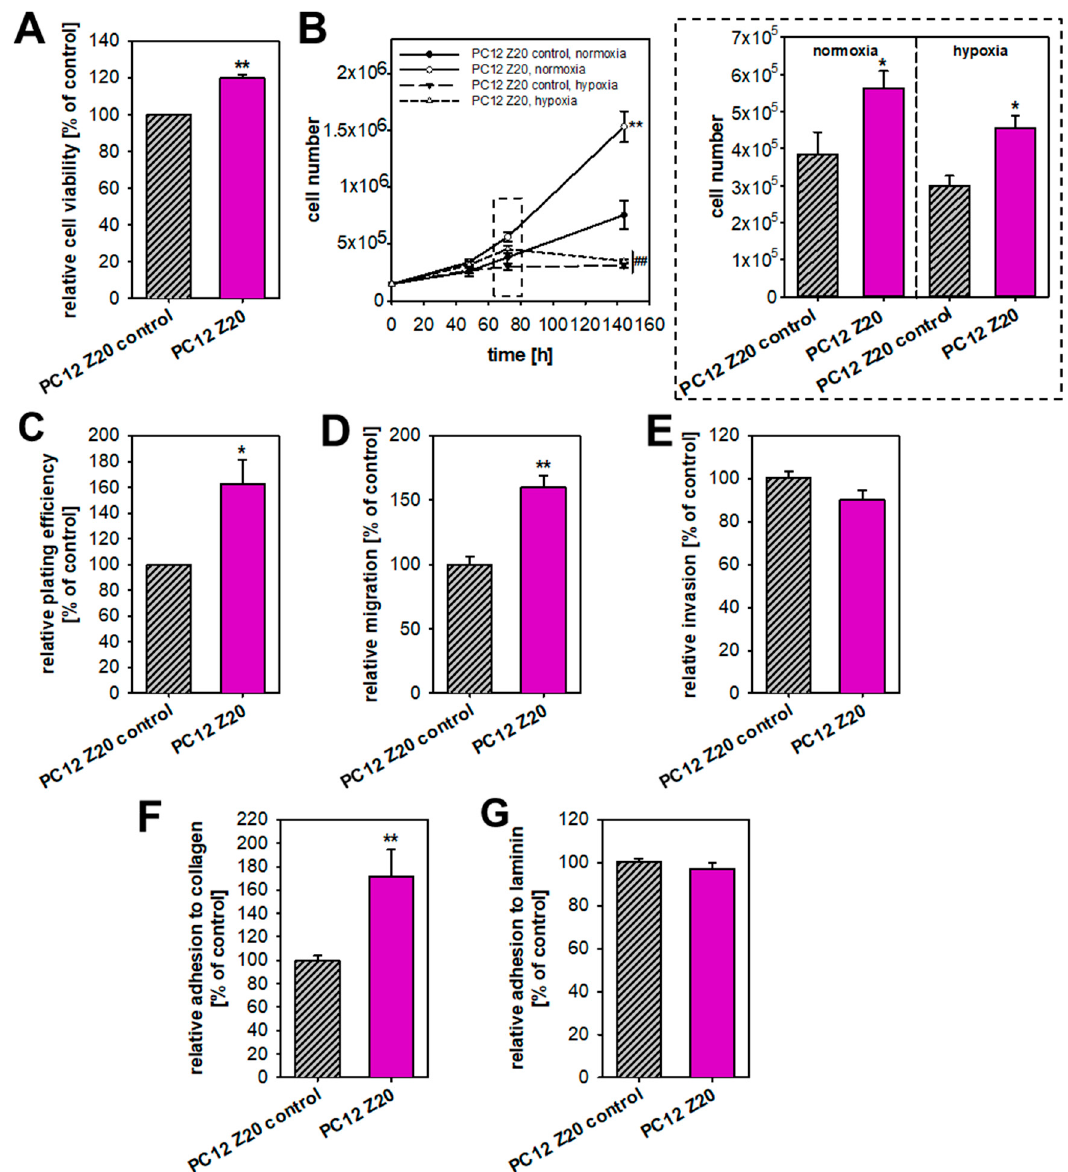
Figure 2. PC12 sub-cell line obtained after 20 hypoxia–reoxygenation cycles revealed enhanced proliferative and pro-metastatic behavior under normoxic conditions compared with control cells. ( A ) PC12 Z20 cells showed an increased cell viability compared with PC12 Z20 control cells. Twelve